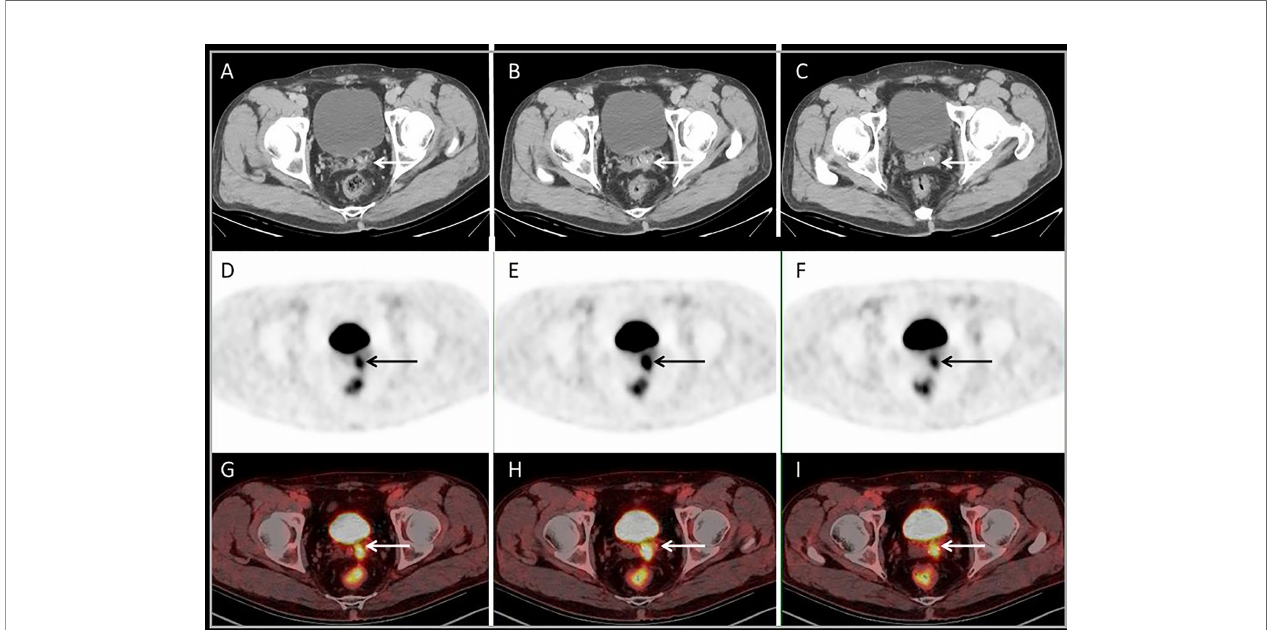
FIGURE 7 | Images of a 52-year-old male with single liver metastasis after surgery of sigmoid cancer resection. Conventional abdomen CT showed no EHD (A – C) . PET and PET/CT fusion images showed a peritoneal nodule adjacent to the left seminal vesicle gland (D – I) . The surgery extent changed from liver only to combining live and peritoneal nodule (minor